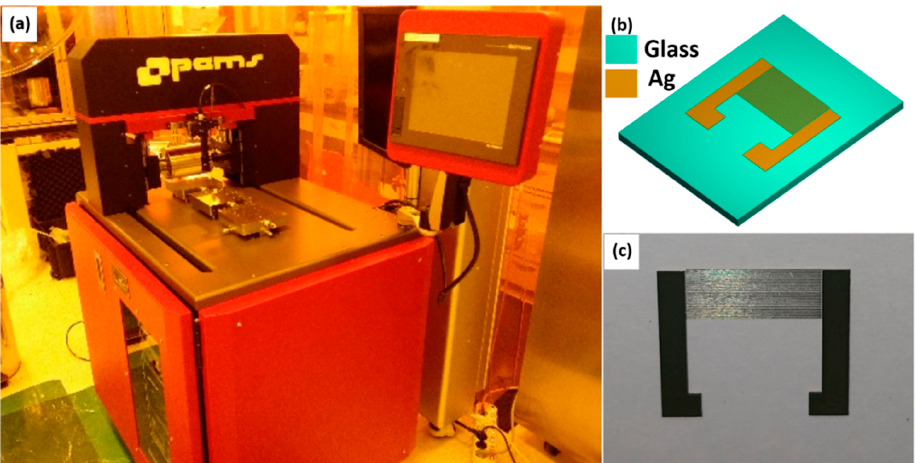
Figure 1. ( a ) Real photograph of reverse-offset printing system, ( b ) CAD design, and ( c ) real photo- graph of the Ag IDTs printed on glass.